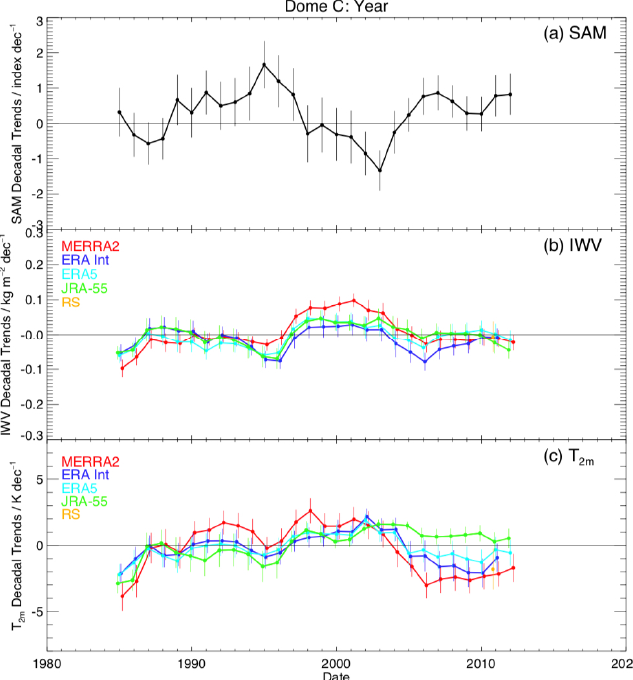
Figure 13. Multidecadal variability of the 10-year trends of ( a ) the SAM index, ( b ) the IWV and ( c ) the near-surface temperature (T 2m ) from the MERRA2 (red), ERA interim (dark blue), ERA5 (light blue) and JRA-55 (green) reanalyses above Dome C from 1980 to 2017 as annual averages. Superimposed are the 10-year trends of the IWV ( b ) and the 10-m temperature ( c ) from the radiosonde data set (orange) from 2005 to 2017. Vertical bars represent 1- σ error.